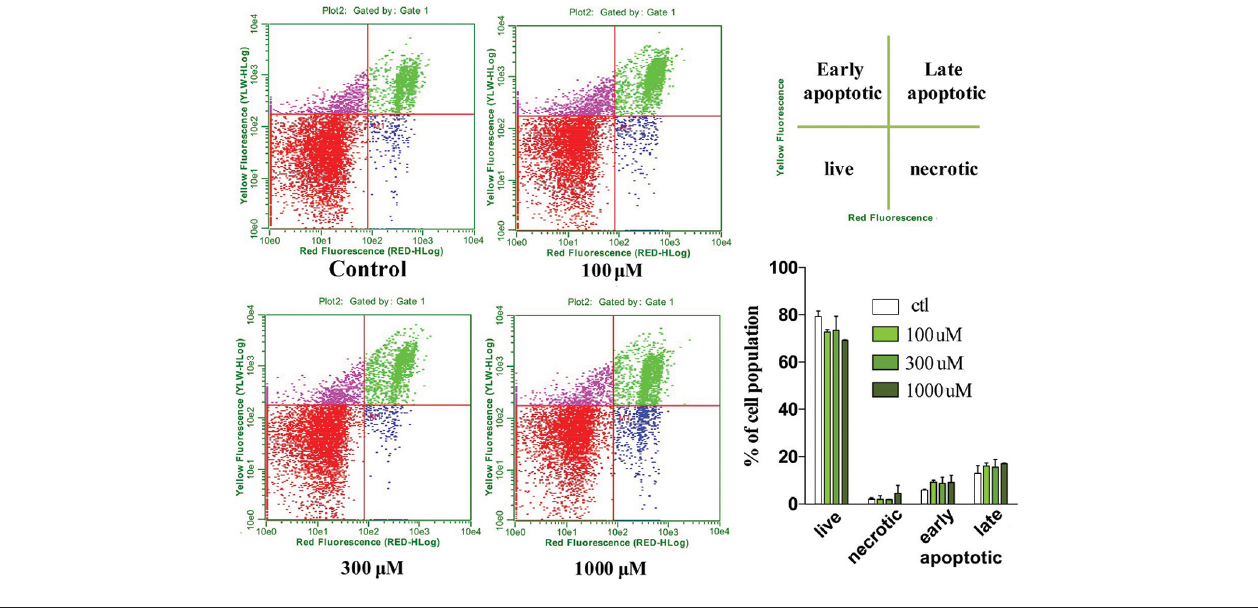
Figure 11. Effect of YD0171 on cell viability and cell death in HCT116 cells. Cells were treated with YD0171 (100, 300 or 1 mmol/L) for 48 h, followed by flow cytometry analysis of phospholipid redistribution by the annexin V/propidium iodide assay. Samples were analyzed for green fluorescence (FITC) and for red fluorescence (PI) by flow cytometry. Typical profiles are represented in the left panels. The bar graph on the right side shows the relative proportions of the live, necrotic, early apoptotic and late apoptotic cell populations; data are shown as mean ± SEM; n =